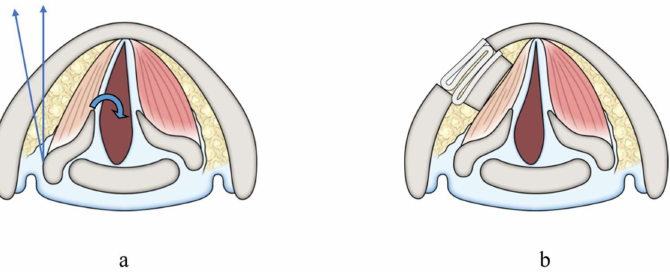
Figure 4. Laryngeal framework surgeries. Laryngeal images of axial plane. ( a ) Arytenoid adduction. We pulled arytenoid cartilage in the direction of the linear arrows, then the vocal fold was rotated at the same median position as the curved arrow. ( b ) Thyroplasty type I. We used a Gore-Tex sheet to push the vocal fold medially through a window opened in the thyroid cartilage. (Citation: Ref.